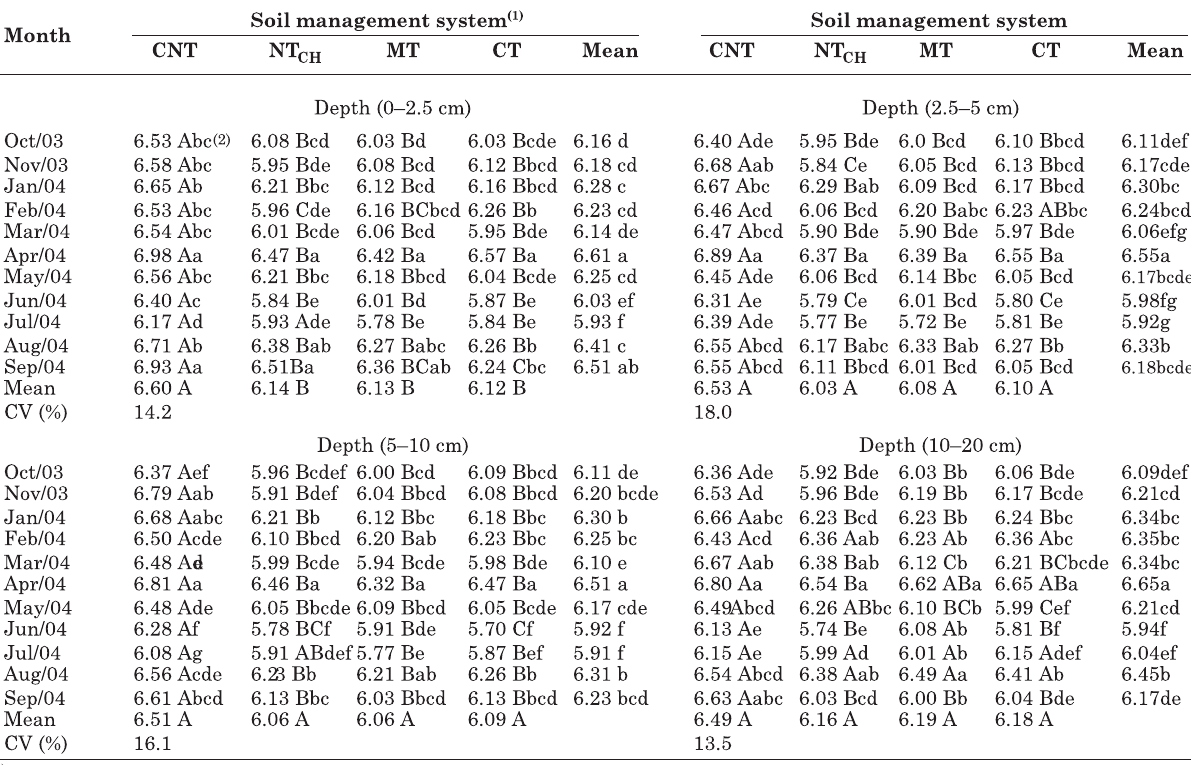
Table 3. Soil pH (in water) as a function of the soil management systems (treatments) in the layers 0–2.5,